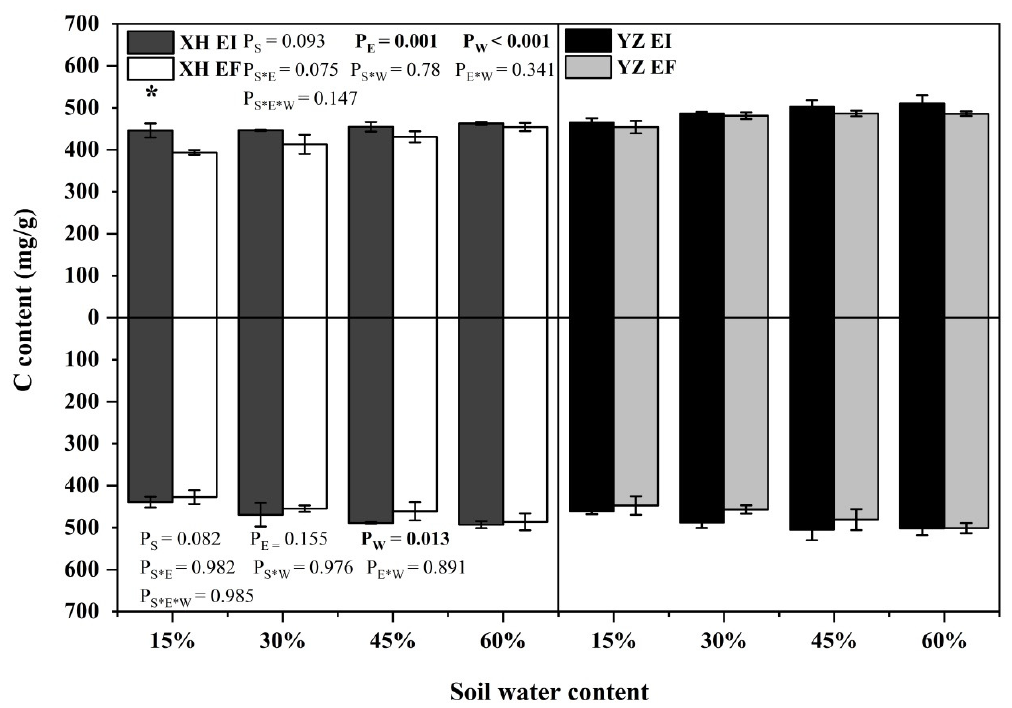
Figure 7. The C content of A. inebrians seedlings shoots and roots from XH(W) and YZ(D) seeds under various soil water content (mg/g). Upwards and downwards bars represent the value of shoot and root part, respectively. The asterisk (*) above error bars means significant difference ( p < 0.05) between EI and EF under the same soil water content.